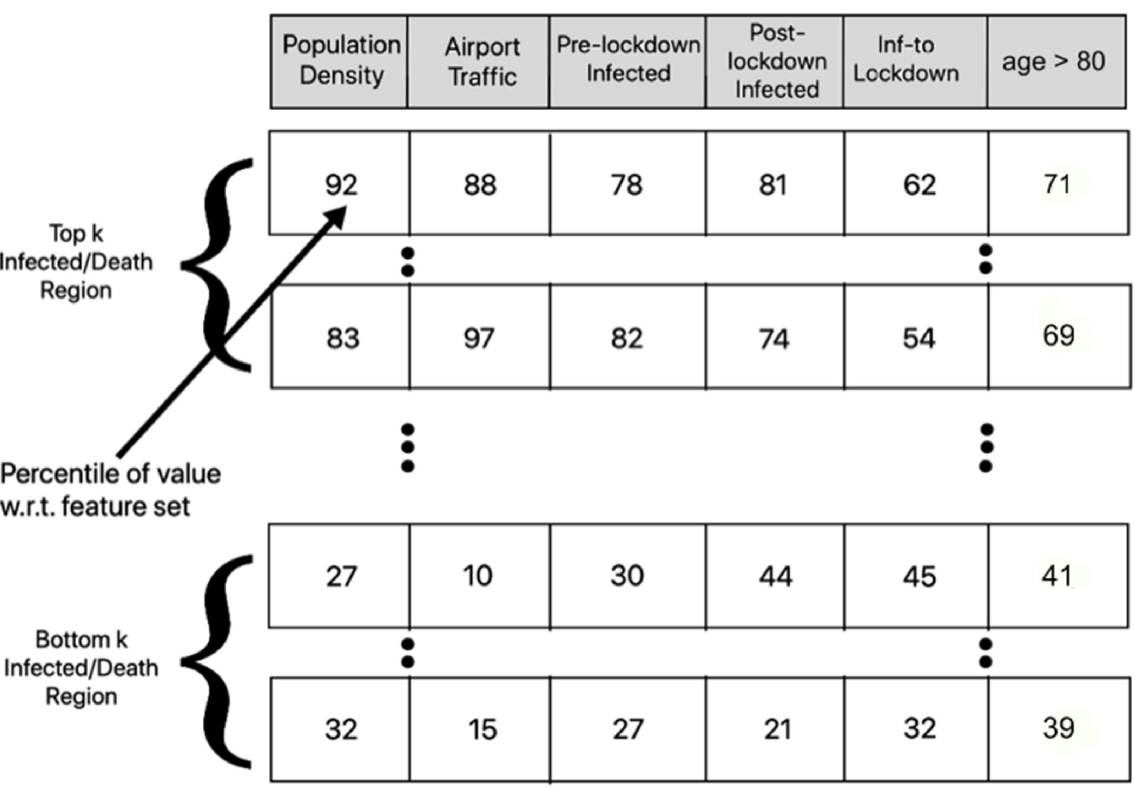
Fig 5. Preprocessing to study the variation in feature values for the top and bottom k US states on the basis of COVID-19 infected and death scores.